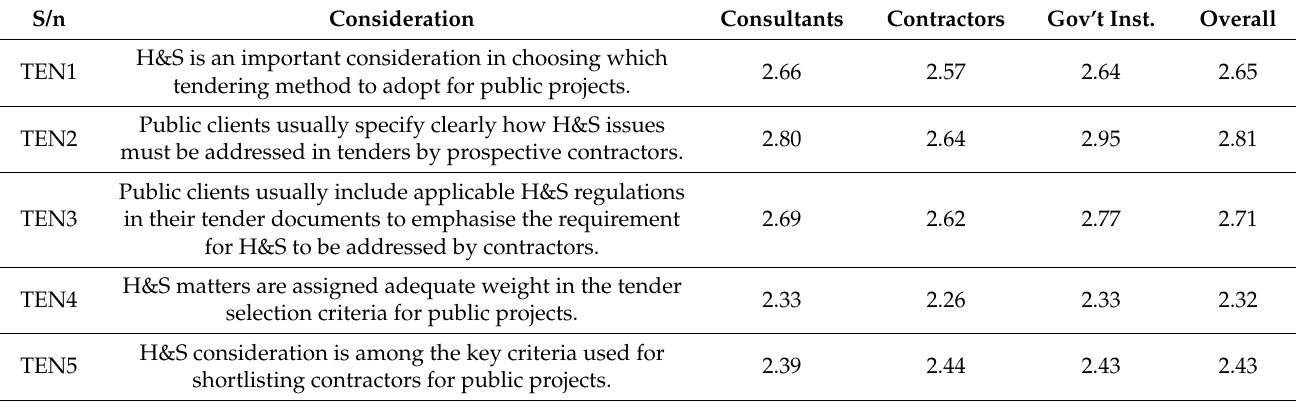
Table 5. H&S considerations at the tendering stage of public